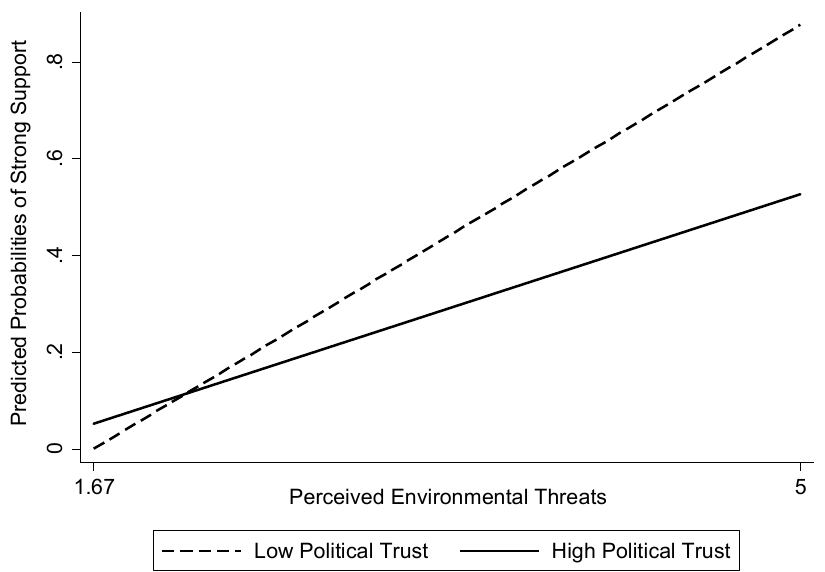
Figure 2. Predicted Probabilities of Strong Support for Perceived Nuclear Threats. In terms of the dashed lines, when the level of political trust is low, the relationship be- tween perceived environmental threats and perceived nuclear threats is steep and strongly positive. The solid line shows that when the level of political trust is high, the relationship between perceived environmental threats and perceived nuclear threats is gradual rather than steep. In other words, as individuals’ perceptions of environmental threats increase, their perceptions of perceived nuclear threats increase, but the degree of that increase is much less steep when individuals place high trust in the